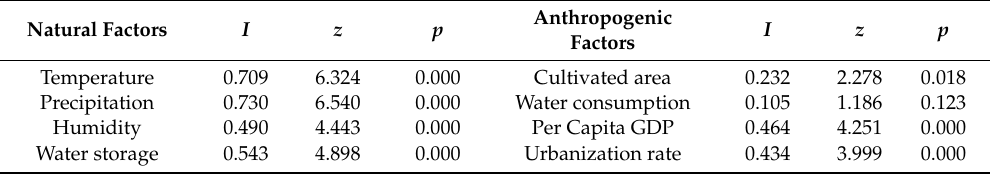
Table 3. Moran’s I test for global association.